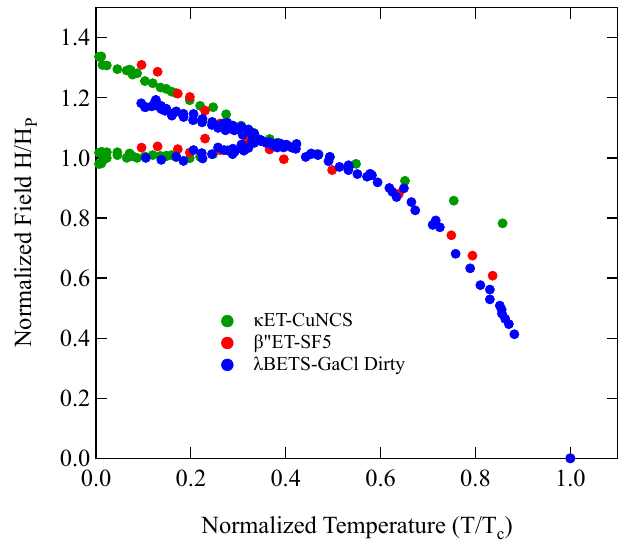
Figure 6. Color online. Phase diagram of κ ET-CuNCS, λ BETS-GaCl and β "ET-SF5 each normalized using the phase line between the vortex and FFLO states. The BETS does not seem to have as much enhancement of the upper critical field as the other two superconductors, which scale